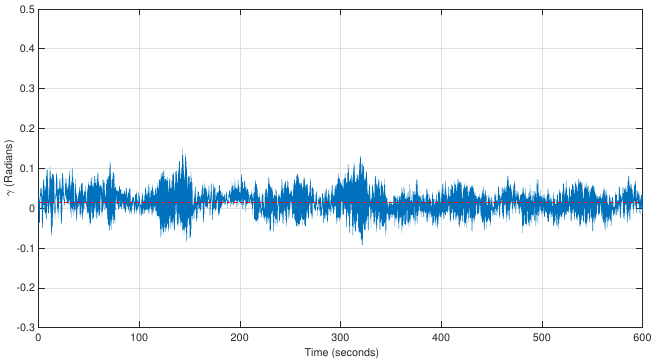
Figure 9. Deviation γ for below-rated wind speed (6